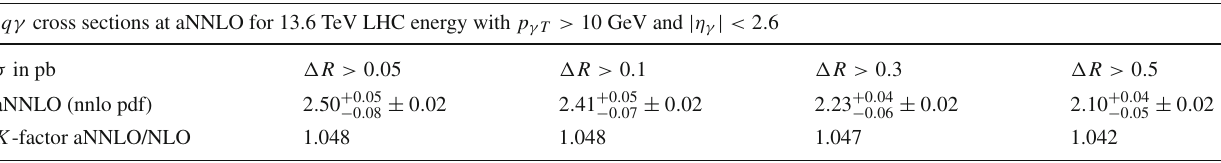
√ S = 13 . 6 TeV, with m t = 172 . 5 GeV and MSHT20 NNLO pdf